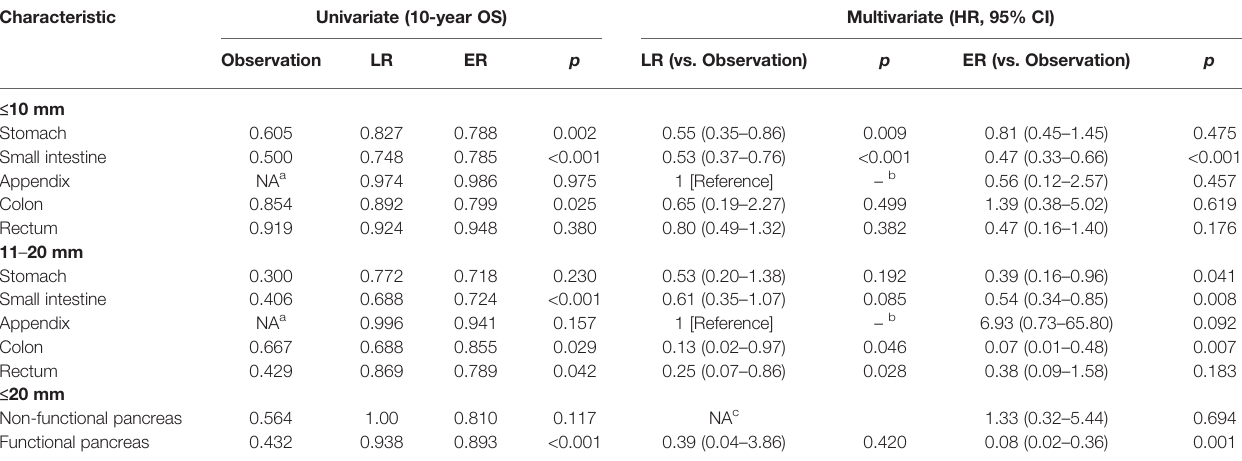
TABLE 3 | Comparisons of different surgical managements strati fi ed by tumor location and size in small well-differentiated GEP-NETs. Characteristic Univariate (10-year OS) Multivariate (HR, 95% CI) Observation LR ER p LR (vs. Observation) ER (vs. Observation)